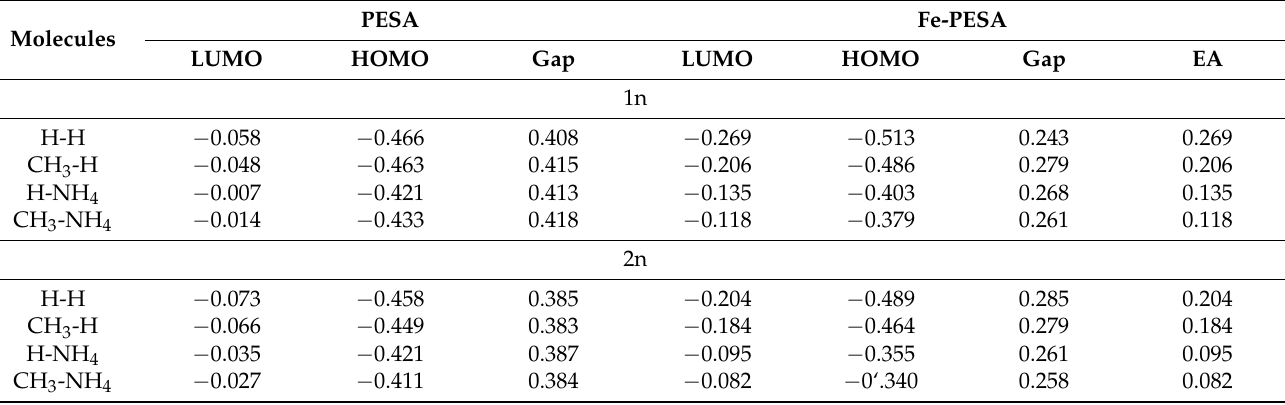
Table 3. The HOMO-LUMO gap of the optimized polymers and their corresponding Fe-complex, and the electron affinity (EA) values for the Fe-PESA complexes only. The energy values are in 1 × 10 − 19 J. Molecules